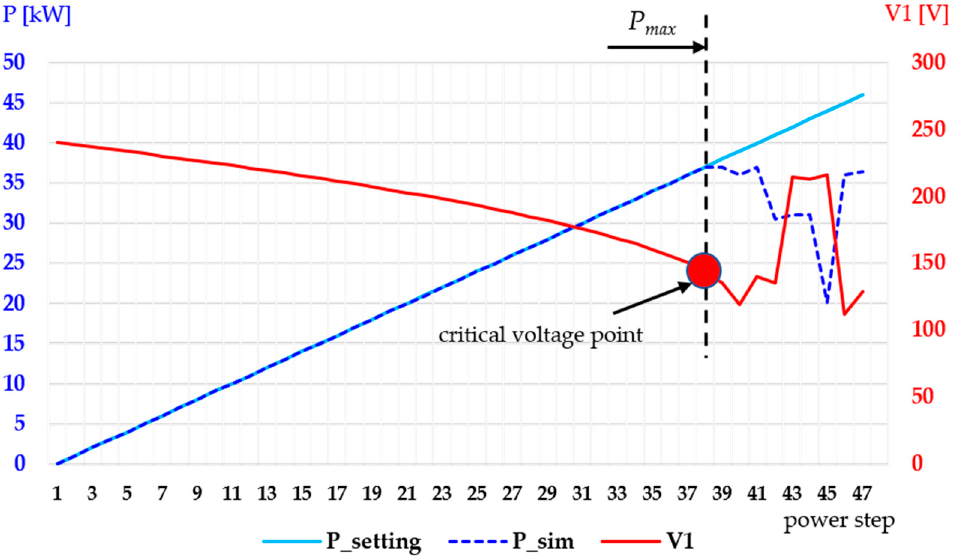
Figure 3. Evolution of microgrid node N3 solutions (voltage versus power) in a power ramp test.